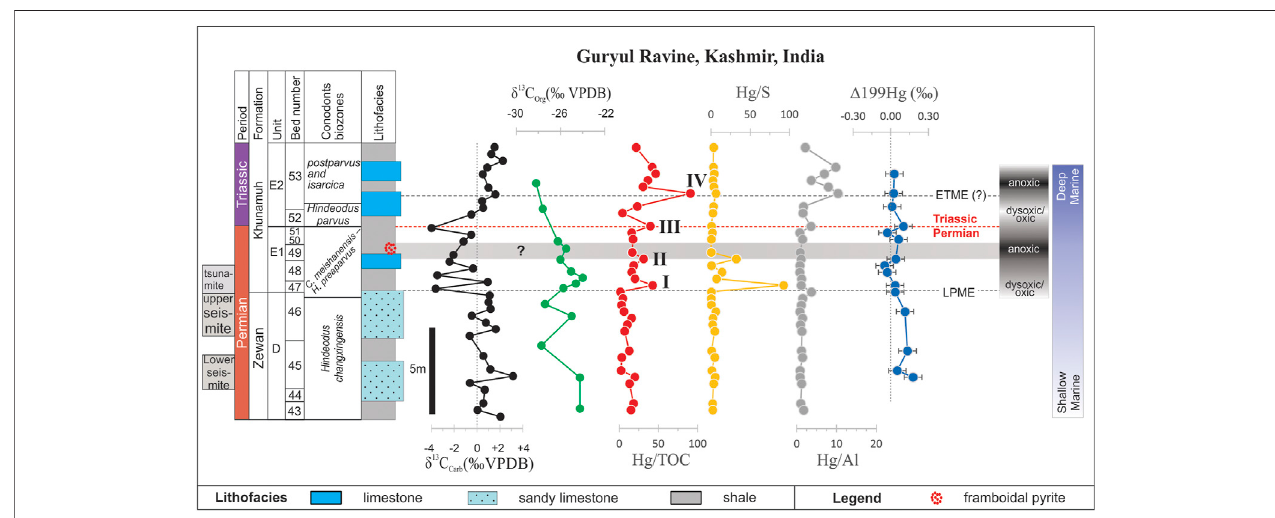
FIGURE 5 | Lithostratigraphy and conodont biozones for the Guryul Ravine section according to Brook fi eld et al. (2019); δ 13 C org curve from Algeo et al. (2007); δ 13 C Δ 199 Hg ‰ (MIF), Hg/TOC, Hg/S ( (cid:1) Hg/TS), Hg/Al chemostratigraphic curves are from this study; variations in the redox carb pathway is from Sial et al. (2020b), conditions are based on Huang Y. et al. (2019), two-marine anoxic events based on the distribution of framboidal pyrite. Relative depth of deposition (shallow, deep) is from Singh et al.